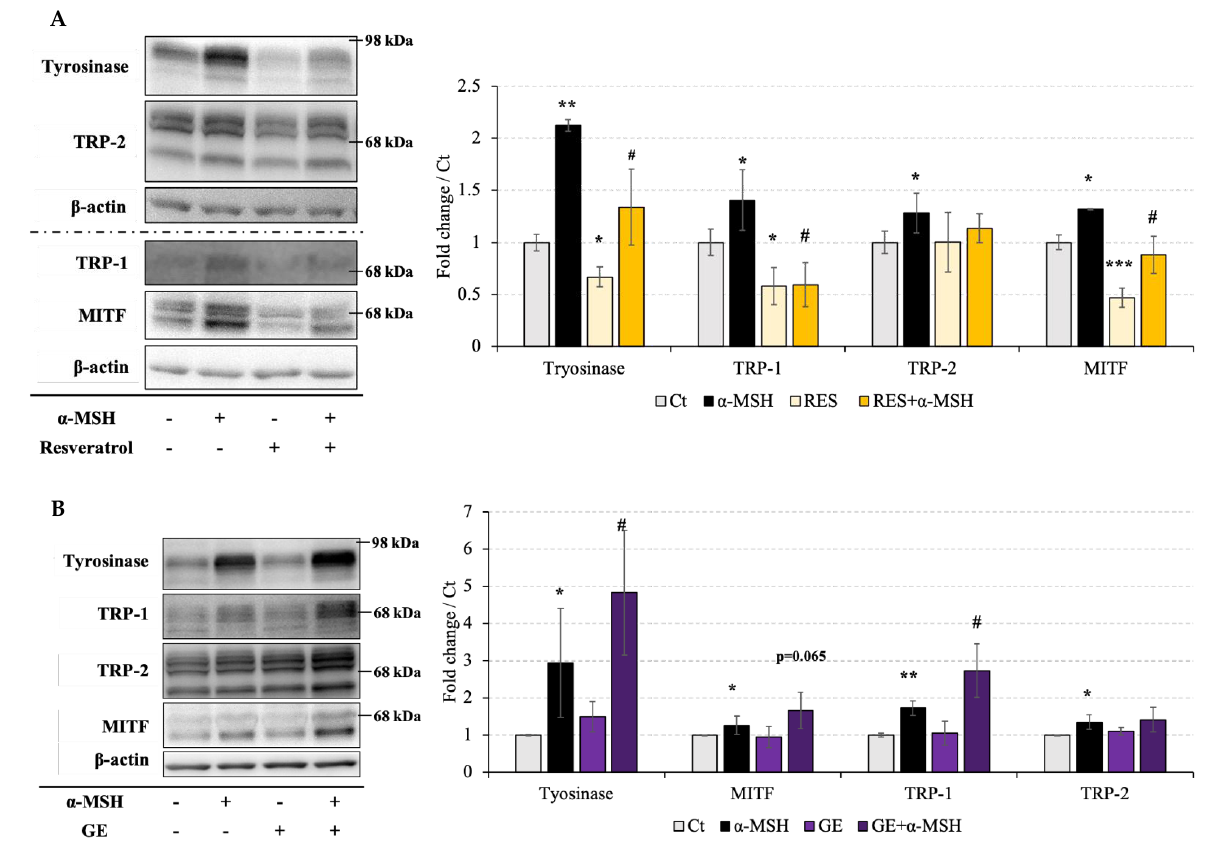
Figure 4. Effect of 72 h treatment with resveratrol (Res; 20 µ M) and grape extract (GE; 100 µ g/mL) on melanogenesis-related gene expression in B16F10 melanocytes. The positive control was α -melanocyte-stimulating hormone ( α -MSH; 10 nM). Western blotting was performed to evaluate the expression of tyrosinase (90 kDa), tyrosinase-related protein-1 (TRP-1) (70 kDa), tyrosinase-related protein-2 (TRP-2) (60–80 kDa), and microphthalmia-associated transcription factor (MITF) (60–80 kDa) following treatment with ( A ) Res and ( B ) GE. The internal control was β -actin. The results are presented as the mean ± standard deviation, n ≥ 3, * p < 0.05, ** p < 0.01, *** p < 0.001 vs. Ct (non-treatment); # p < 0.05 vs. α -MSH.